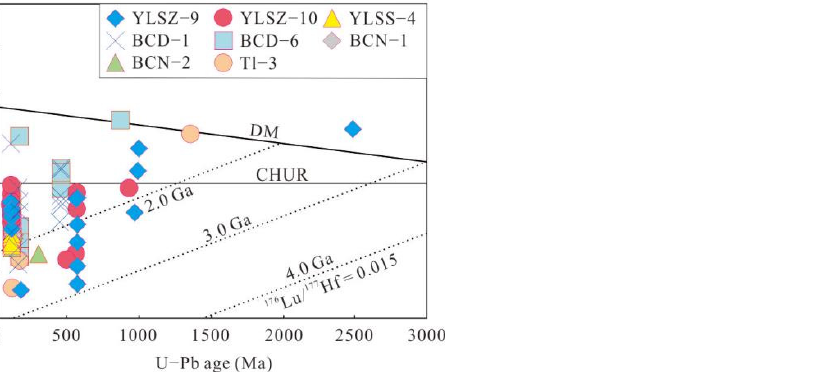
Figure 5. Zircon ε Hf (t) versus U–Pb age diagram for the Yilashan and Amdo granitoids in the Nagqu area. DM: depleted mantle; CHUR: chondritic uniform reservoir.